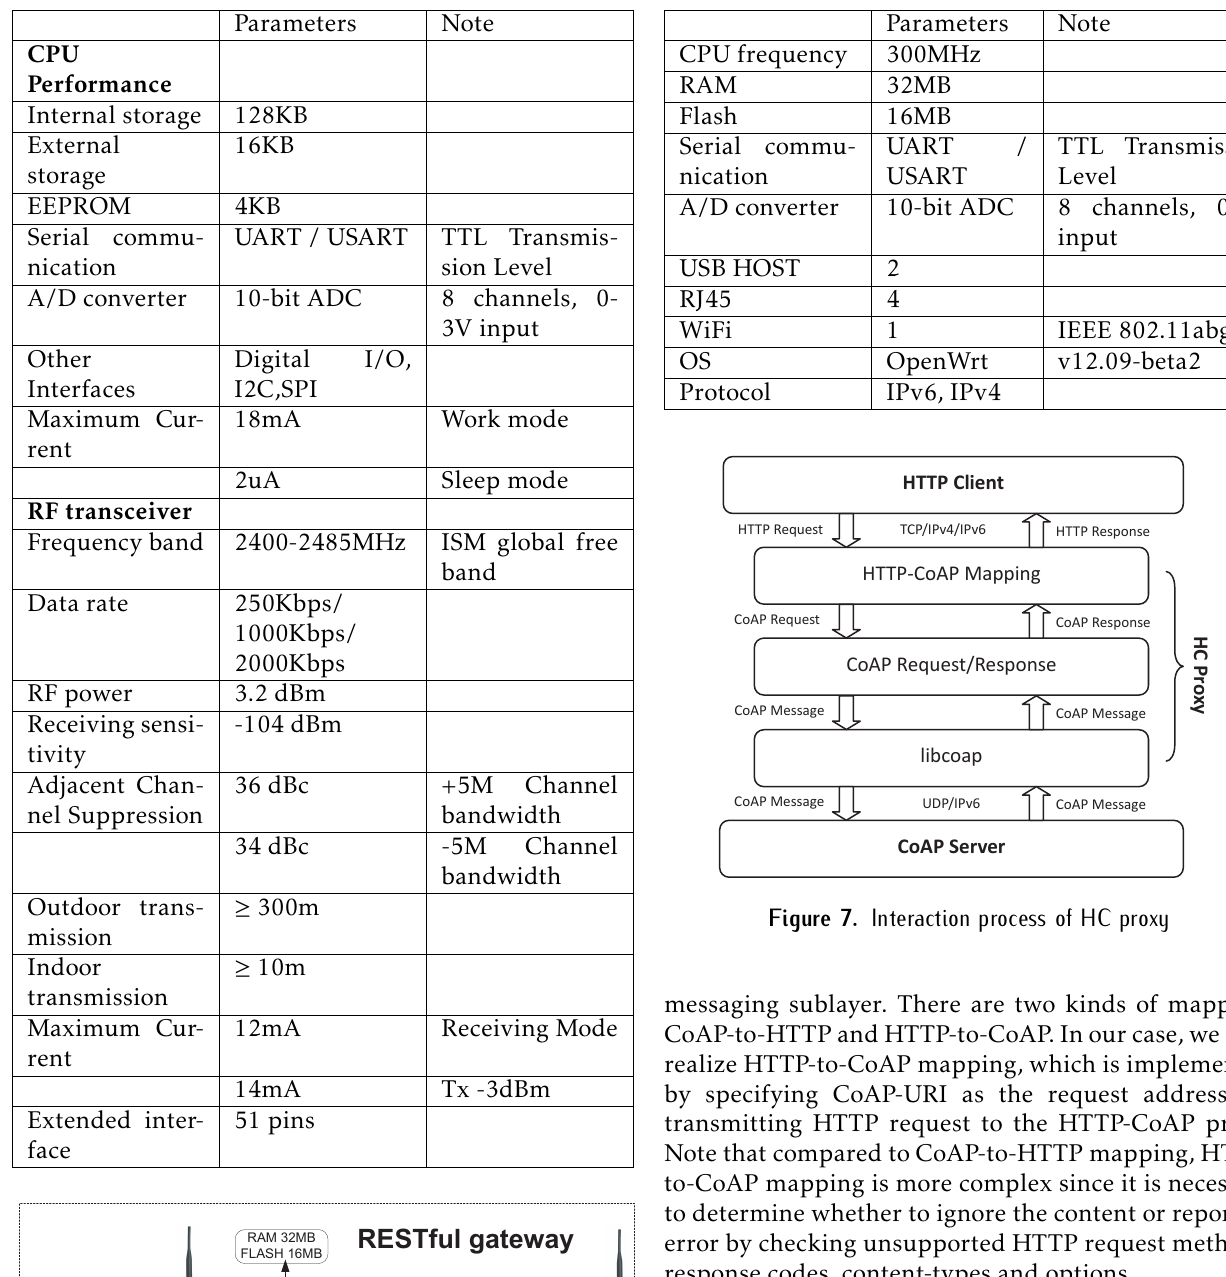
Table 2. Technical specifications of sensor device